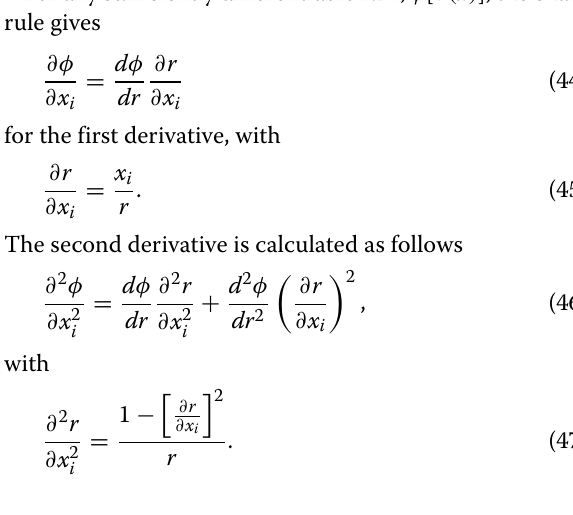
Table 7 PSNR value of the restored image “Lena” with optimal values of c and λ is 26.01. Parameter sensitivity analysis for our proposed method M3 by percentage increased in values of the parameters c and λ , with the resultant percentage increase or decrease in PSNR of the denoised image of size ( 400 2 ) Image